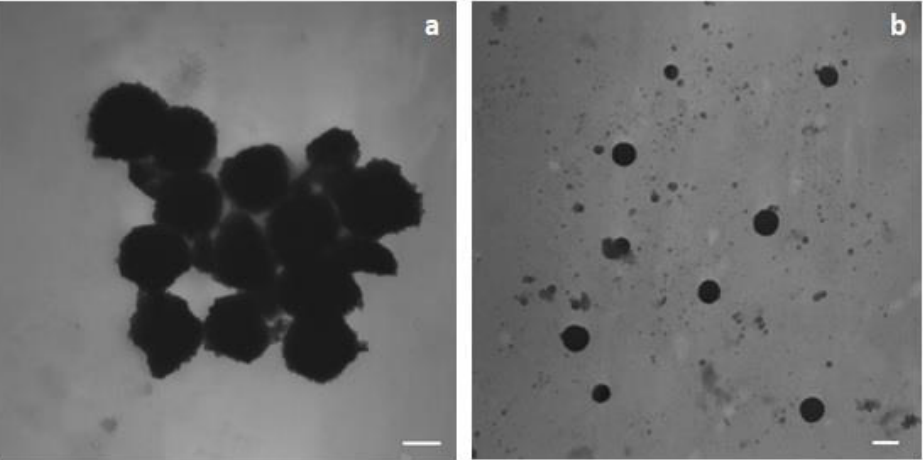
Figure 3. TEM image of B-SLNc ( a ) and G-SLNb ( b ). ( a ) Magnification 39000; scale bar 150 nm; ( b ) magnification 15500, scale bar 300 nm.